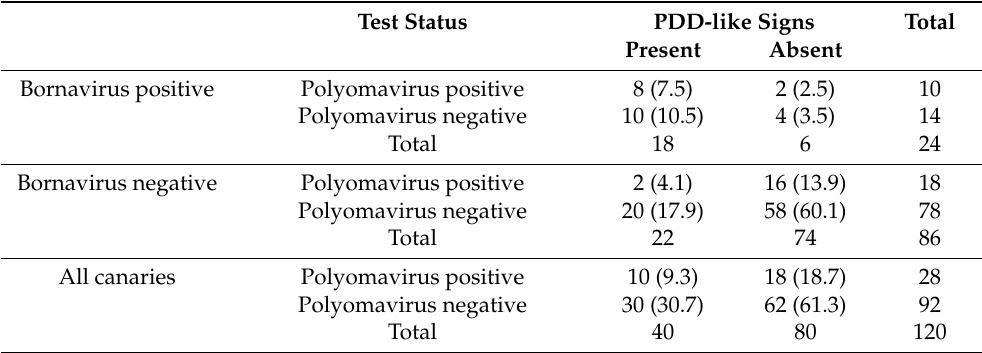
Table 7. Cross table for the number of canaries with positive or negative bornavirus tests, as well as polyomavirus tests, and occurrence of proventricular dilatation disease (PDD)-like signs. Expected counts for perfectly independent variables are given in